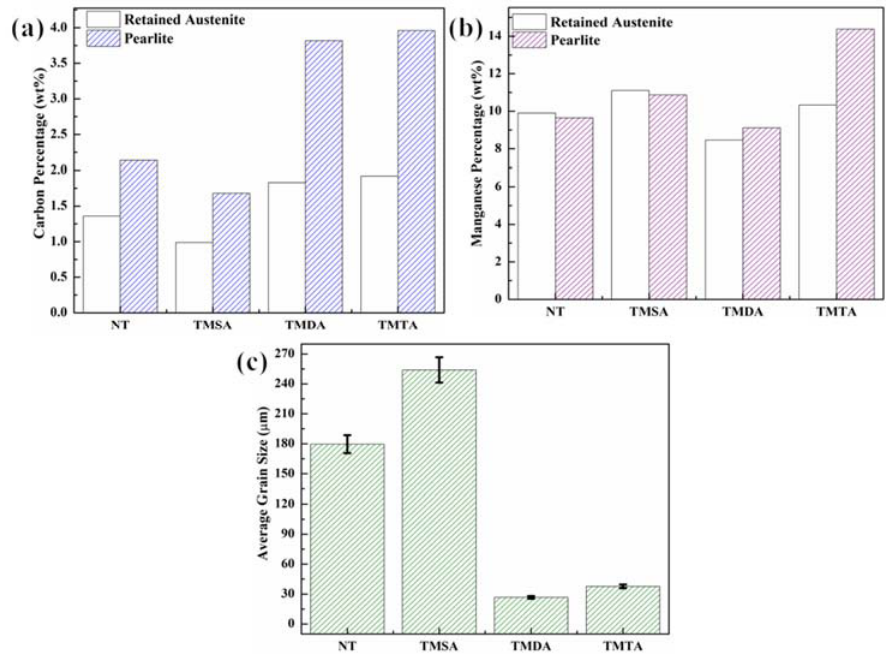
Figure 5. Plot of ( a ) carbon, ( b ) manganese percentages in retained austenite and pearlite phases, and ( c ) average grain size of microstructure achieved after various TMCA processes.